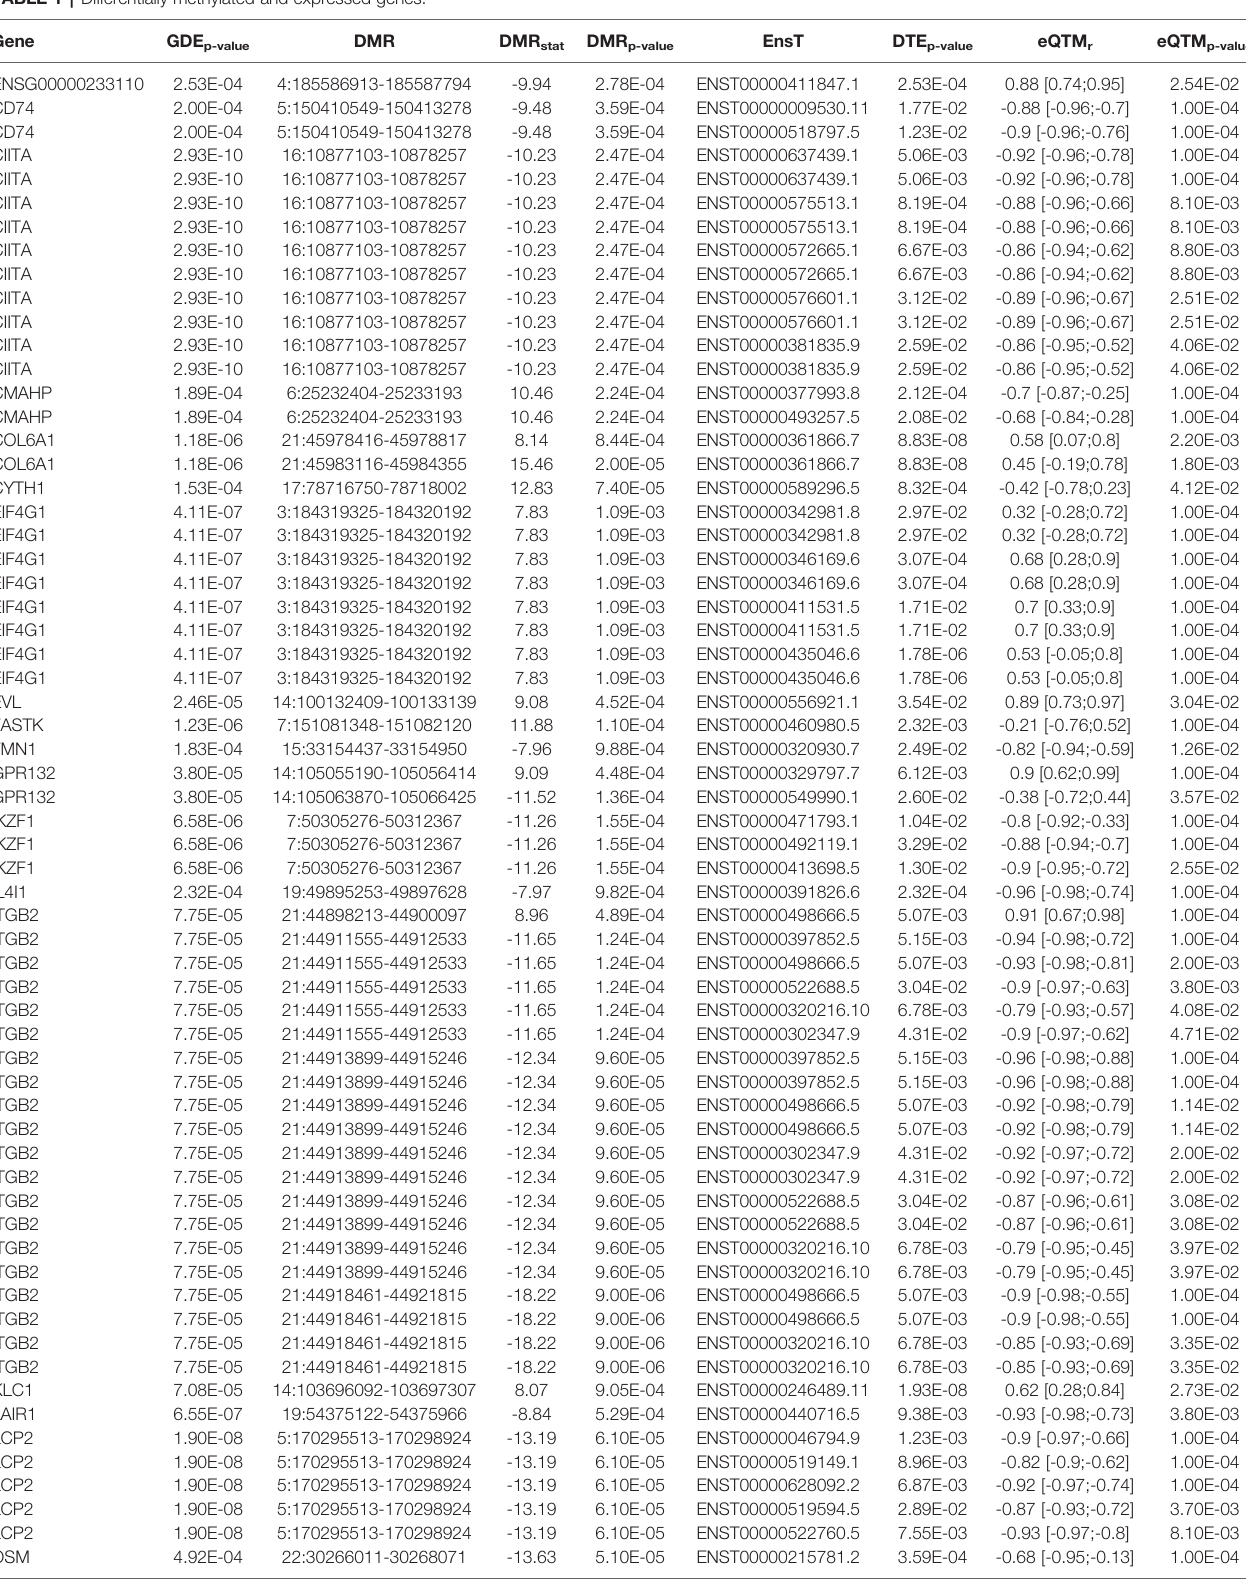
TABLE 1 | Differentially methylated and expressed genes.